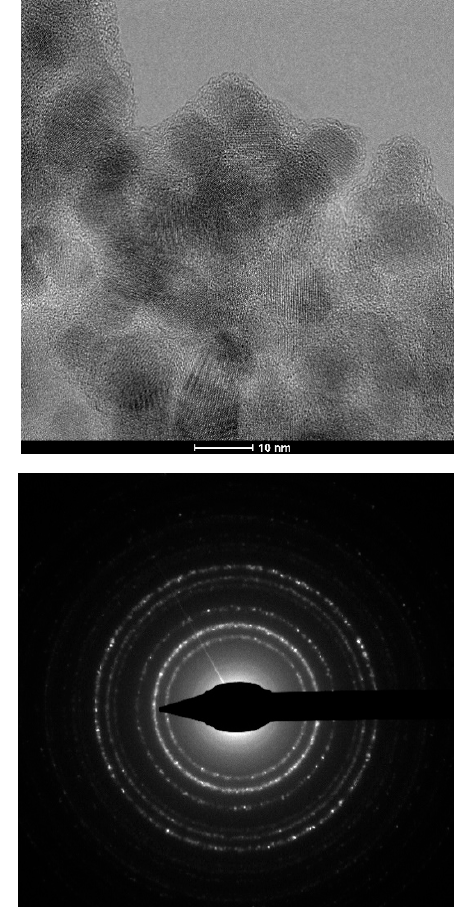
proximately 2 nm. The crystal structure of Fe 3 O 4 is confirmed by the SAED image.